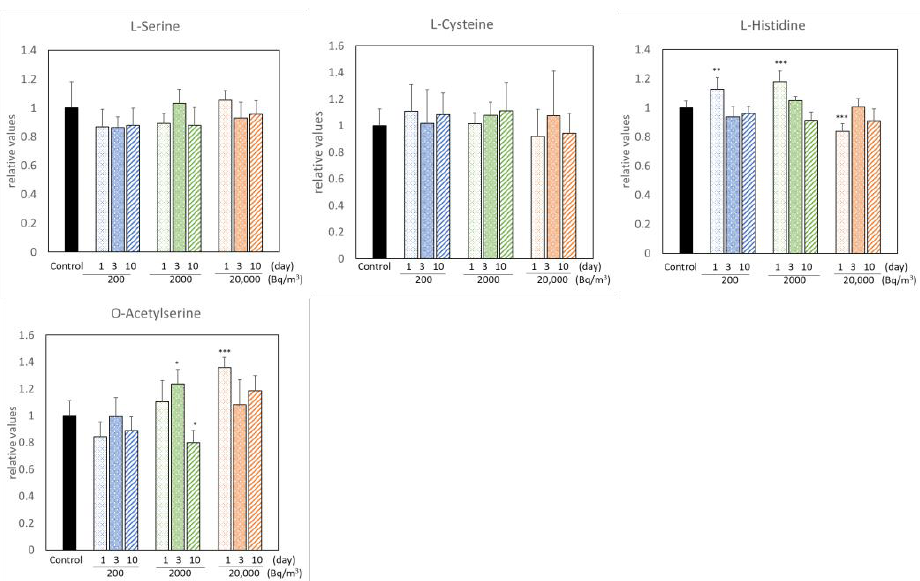
Figure 3. Metabolites with incoherent changes by radon inhalation. The number of mice per experimental point is six. All quantitative data are presented as mean ± SD. * p < 0.05, ** p < 0.01, *** p < 0.001. vs. control.